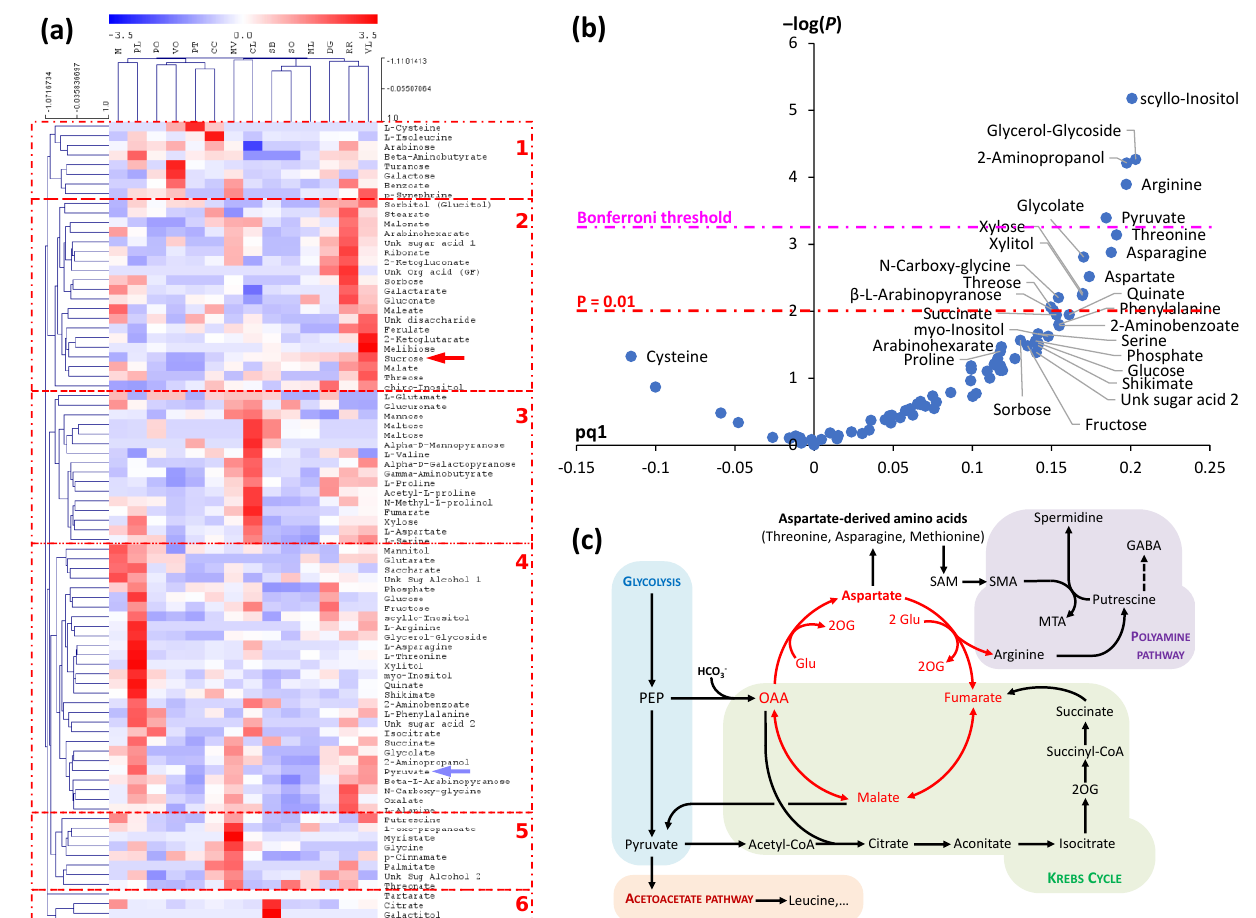
Figure 2. Metabolic analysis of phloem sap in Citrus . ( a ) Hierarchical clustering analysis showing covariation groups of metabolites when sap composition changes between cultivars. Sucrose and pyruvate are shown by red and blue arrows, respectively. ( b ) Volcano plot combining univariate (–log p -values) and multivariate (orthogonal partial least square (OPLS) loadings, pq1) analyses to identify best drivers of total phloem concentration (which increases from left to right). p -value thresholds (0.01 and Bonferroni) are shown with dash-dotted lines. ( c ) Simplified aspartate cycle (red) and its connections to other pathways. Abbreviations: 2-OG, 2-oxoglutarate; GABA, 4-aminobutyrate; Glu, glutamate; MTA, S-methyl thioadenosine; OAA, oxaloacetate; PEP, phosphoenolpyruvate; SAM, S-adenosyl methionine; SMA, S-adenosyl methioninamine. This figure has been generated by re-analysis of the original dataset in [59] , using MeV (ANOVA) and Simca ® (OPLS).